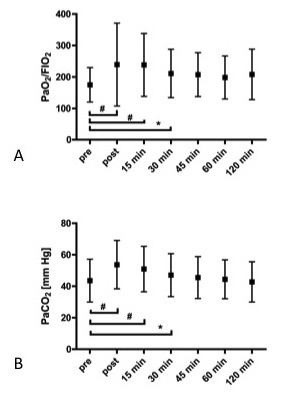
Changes of PaO2/FiO2 (A) and PaCO2 (B), values given as mean ± SD. #: P < 0.001 compared to baseline; *: P < 0.05 compared to baseline.